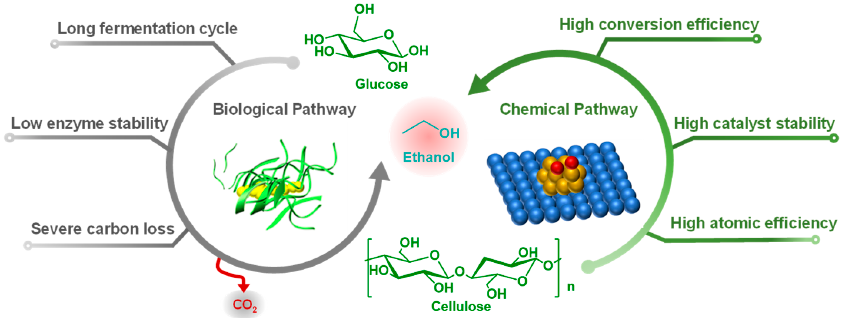
Figure 1. The production of ethanol via biological and chemical